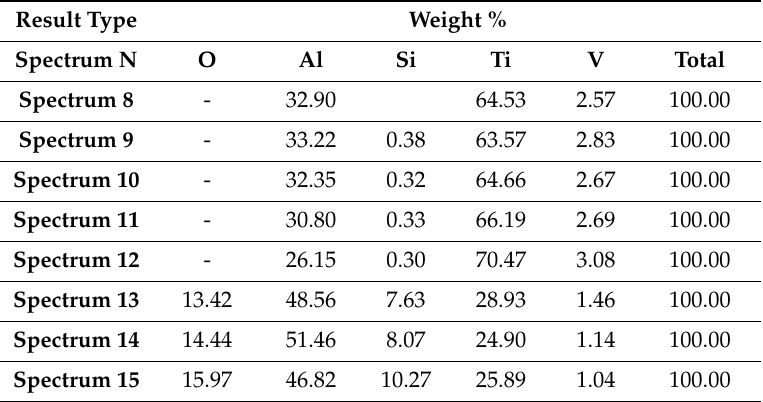
Table 2. The results of EDS analysis.